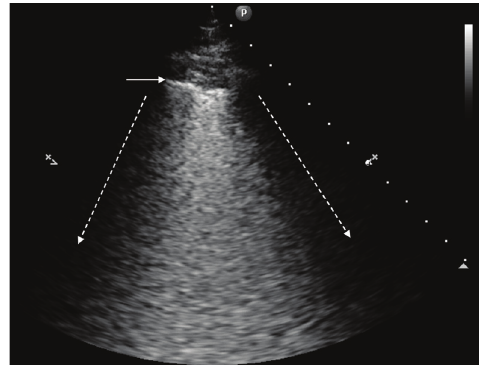
Figure 3. Ultrasound image of the upper right lobe. The dotted arrows indicate the rib shadows. The horizontal arrow indicates the pleura. Between the dotted arrows B-lines can be seen in a pattern called ground-glass rockets, showing an interstitial